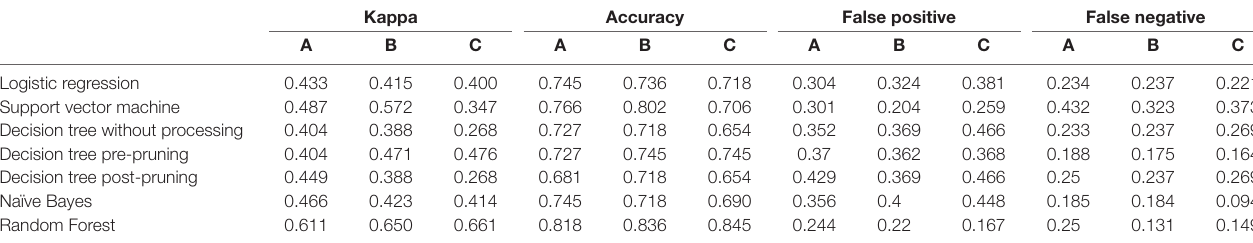
TABLE 4 | Confusion matrix results showing kappa, accuracy, false positive, and false negative rate for each machine learning model using the test dataset. Kappa Accuracy False positive False